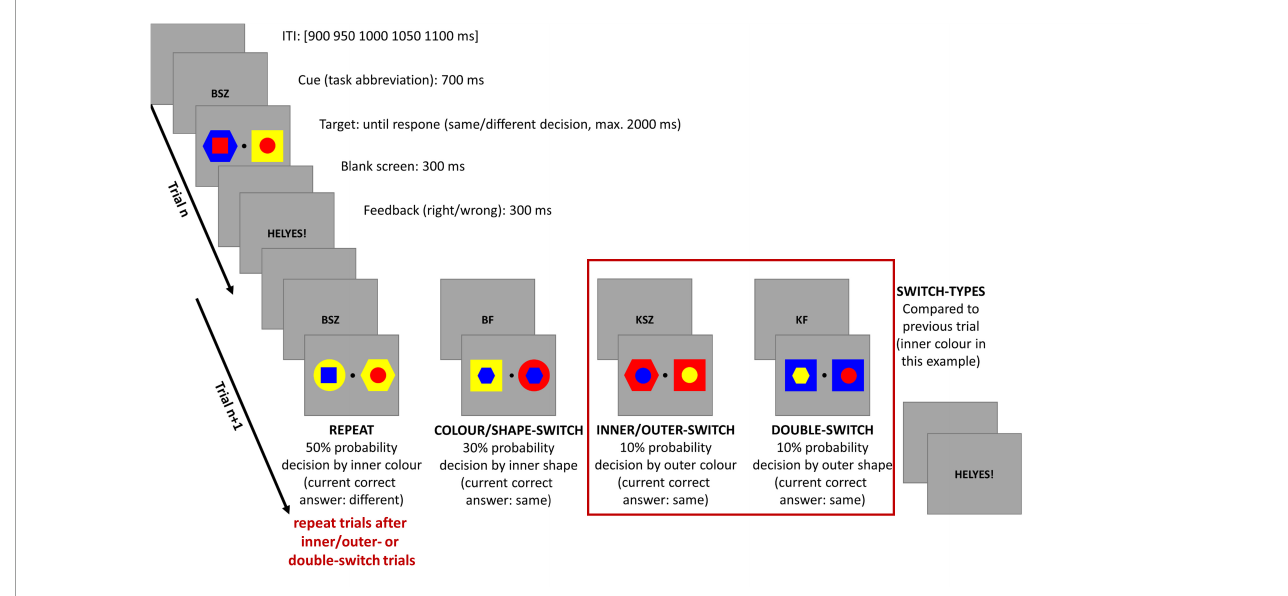
FIGURE1 Illustration of the sequence and timing of stimuli in single and mixed trials. ITI is for intertrial interval. The red frame shows those switch-types which were analyzed in the current study. Only those repeat trials were used which were followed by an inner/outer- or double-switch trial. For a detailed description see the text